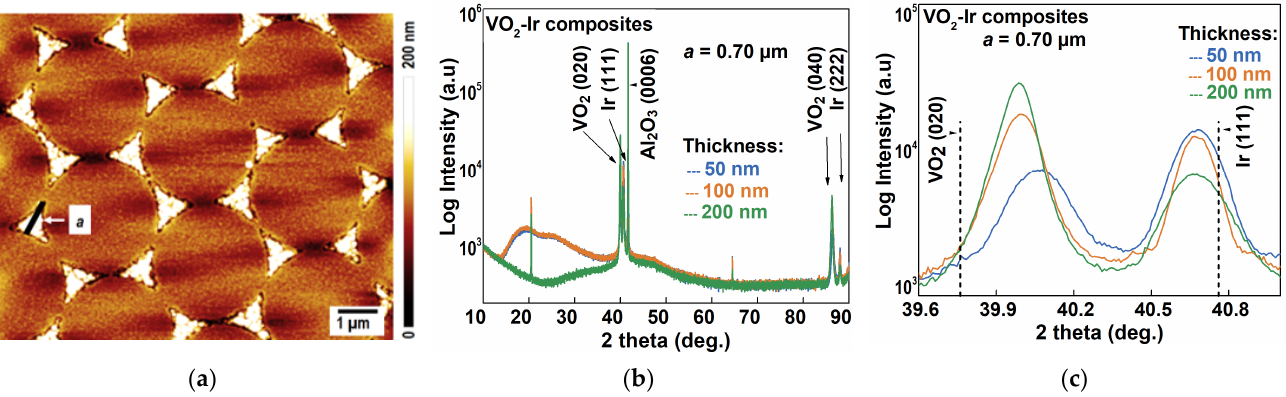
Figure 3. VO 2 –Ir microtriangles composite’s morphological and structural characteristics: ( a ) AFM image; ( b ) θ -2 θ XRD patterns; ( c ) Zoom on a part of ( b ) XRD patterns from 39.6 ◦ to 41 ◦ θ -2 θ XRD patterns of the composite. The thickness of the Iridium triangles within the composite is fixed to 50 nm, while the VO 2 thickness is 50, 100 and 200 nm. The dotted lines in image ( c ) correspond to the theoretical position of VO 2 and